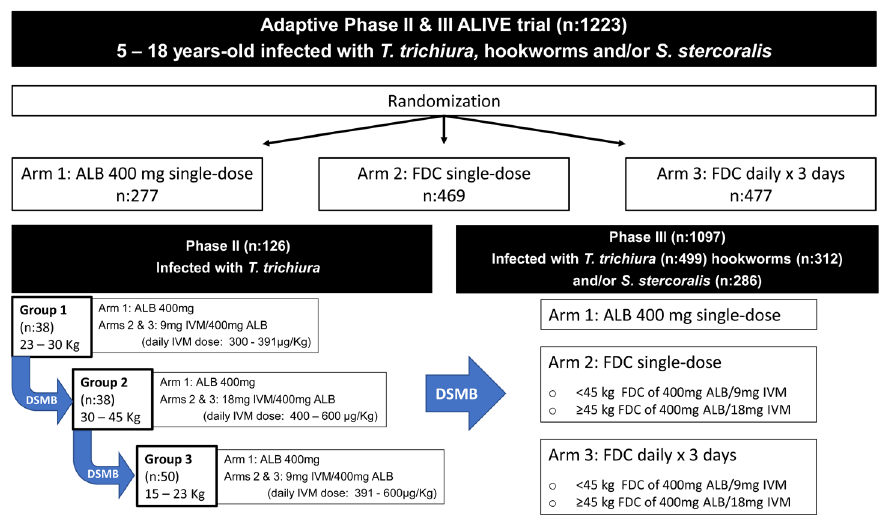
Figure 1. Flow diagram of the phase II & III trials, including participant sample size and randomization in three treatment study arms, dose escalation in phase II based on weight stratification, and targeted soil-transmitted helminth (STH) species in both trials. Abbreviations: ALB, albendazole; FDC, fixed-dose albendazole-ivermectin combination; DSMB, Data Safety Monitoring